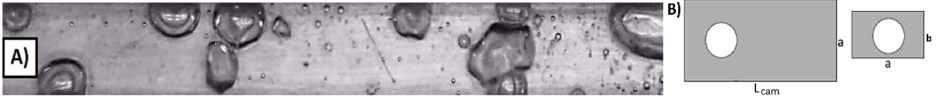
Figure 5. ( A ) Actual and ( B ) approximated shapes of vapor bubbles in longitudinal and transverse sections of the channel with flow direction, case I. Water, T in = 63.1 ◦ C, T out = 123.8 ◦ C, p in = 1.165 bar, ∆ p = 0.0024 bar, q = 298.7 kW / m 2 , G = 7.2 kg / (m 2 s), Re = 55.0, L